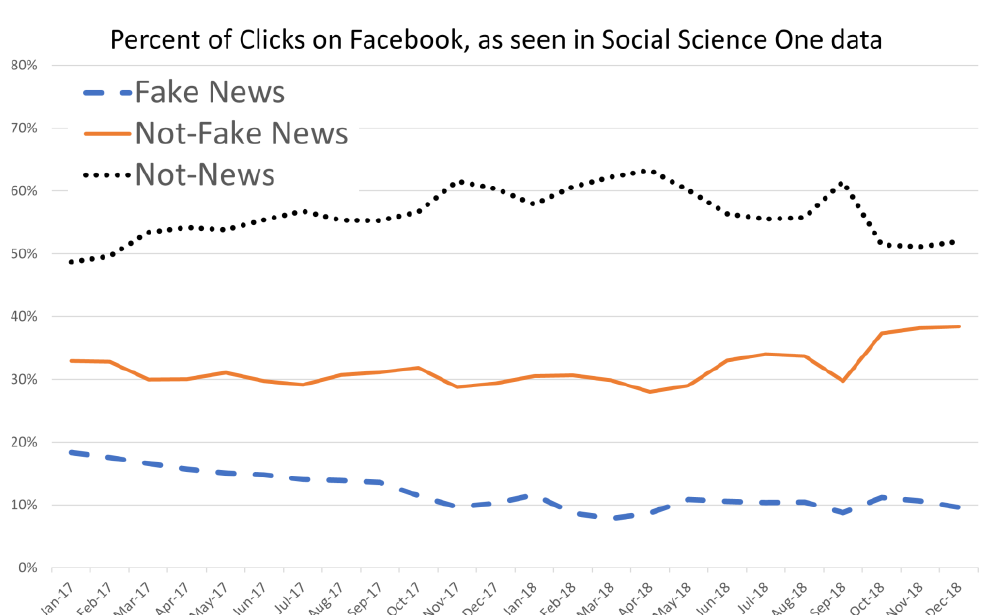
Figure 1. Estimated percentage of clicks on Facebook for fake news, not-fake news, not-news using the raw Facebook URLs data from January 2017 through December